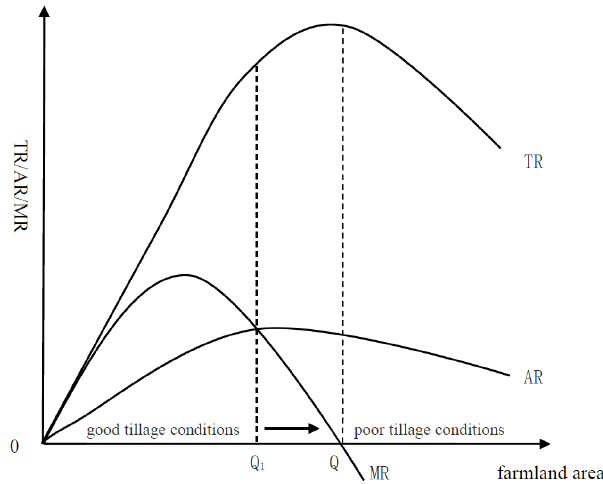
Figure 3. Influence of tillage conditions on cultivated land abandonment.